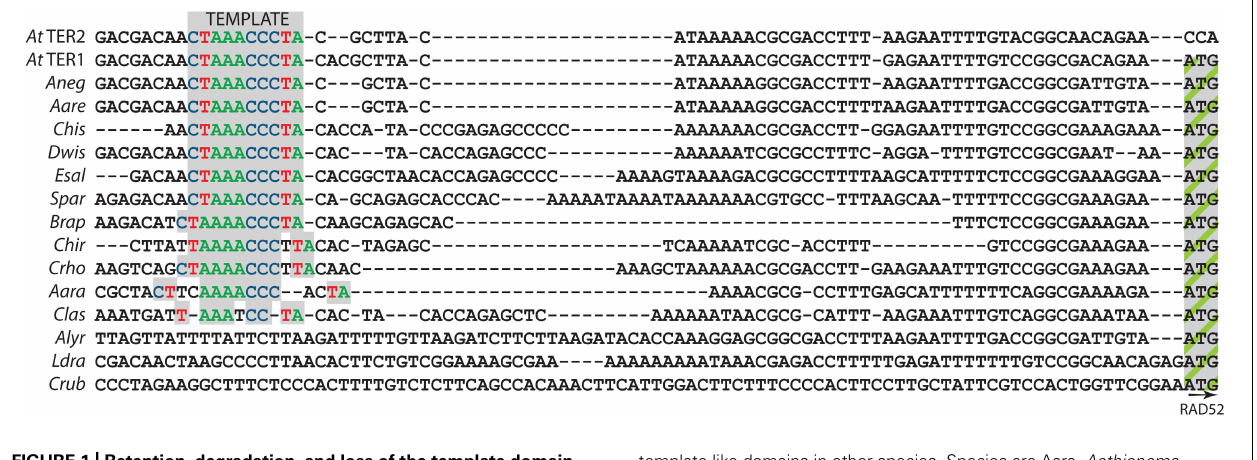
FIGURE 1 | Retention, degradation, and loss of the template domain within putative BrassicaceaeTER genes. Partial sequence alignment of TER1,TER2 and the correspondingTAD3–RAD52 intergenic region in Brassicaceae species is shown. Sequence similarity through the start codon of RAD52 (far right) is indicated.The colored nucleotides indicate the template domain in A. thaliana TER1 andTER2, and the putative template or